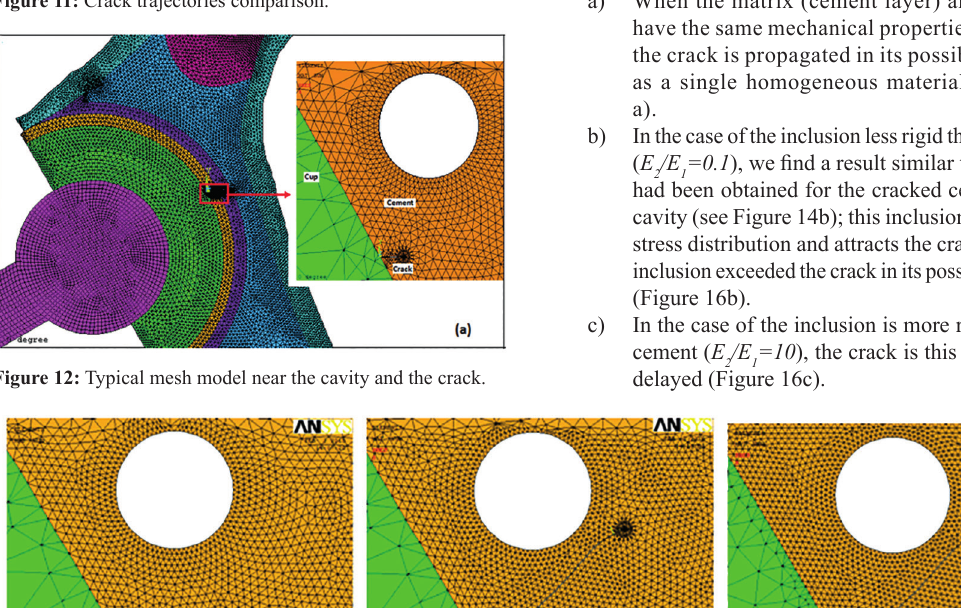
Figure 11: Crack trajectories comparison.